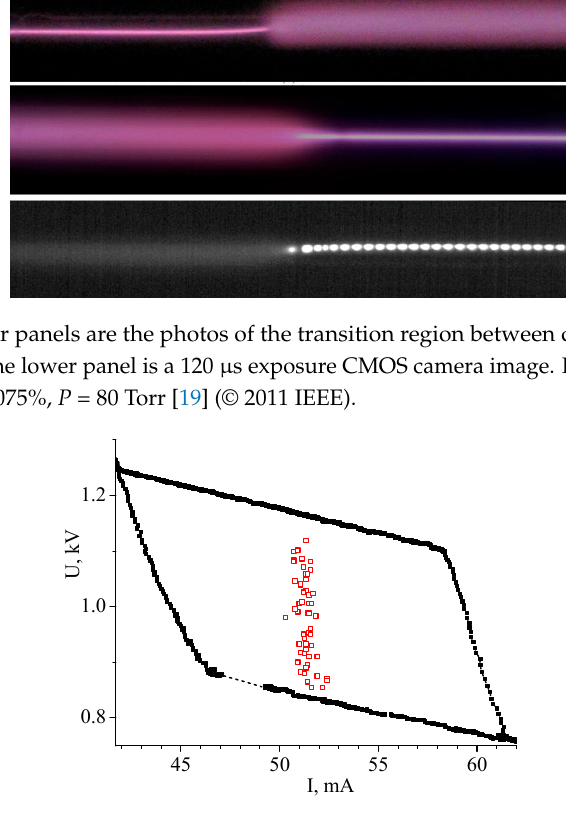
Figure 14. Manifold of PCD points (open squares) for the discharge in the Ar + 0.02%N 2 mixture at P = 50 Torr [16]. (© IOP Publishing. Reproduced with permission. All rights reserved.)